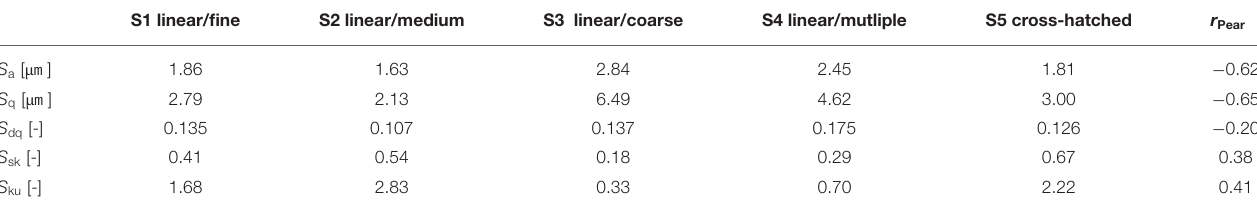
TABLE 4 | 3D roughness information from topographical scans h ( x , y ) of the ski soles S1–S5 measured by white light interferometry and post-processed by Fourier filtering. S1 linear/fine S2 linear/medium S3 linear/coarse S4 linear/mutliple